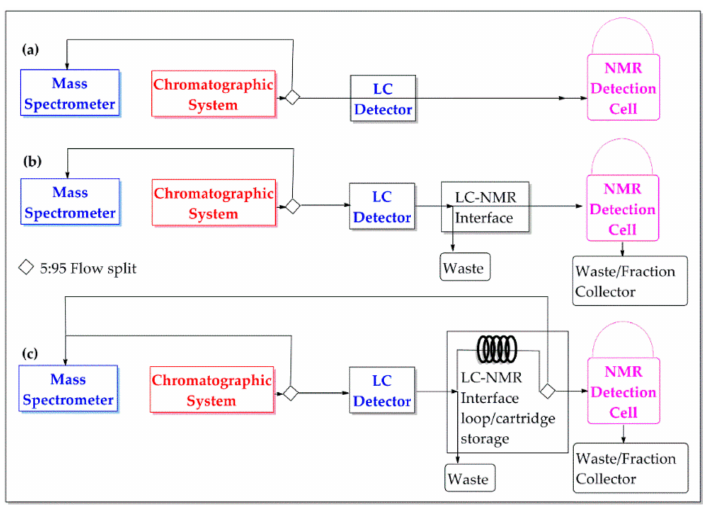
Figure 2. Schematic setups of the different LC–NMR working modes with parallel mass spectrom- eter (MS) detection: ( a ) online/continuous-flow mode, ( b ) stop-flow mode and ( c ) loop/cartridge storage